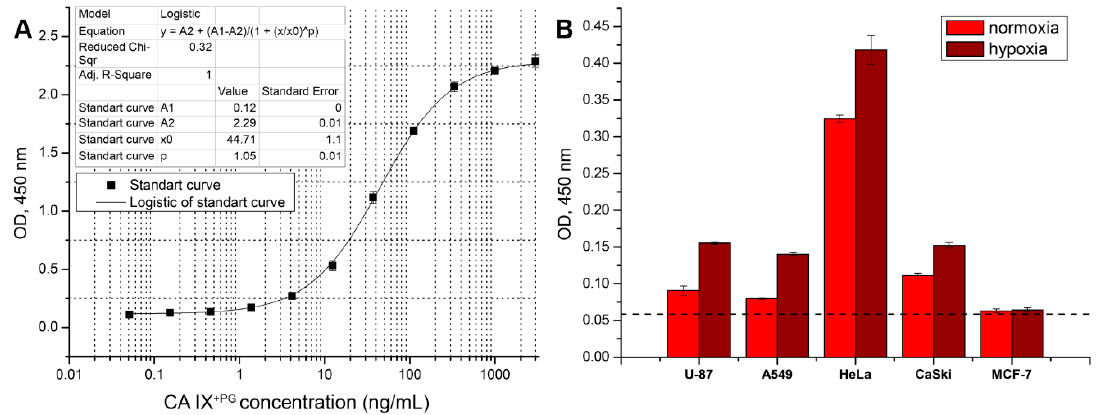
Figure 4. ( A ) Calibration curve obtained after optimization with selected A3 and HRP-labeled MAb H7 pair. Recombinant CA IX +PG protein was used as a standard. ( B ) Application of developed sandwich ELISA for the detection of the soluble CA IX in the culture media of various cancer cells after 10 days cultivation in the normoxic and hypoxic conditions. Dashed line represents background level.